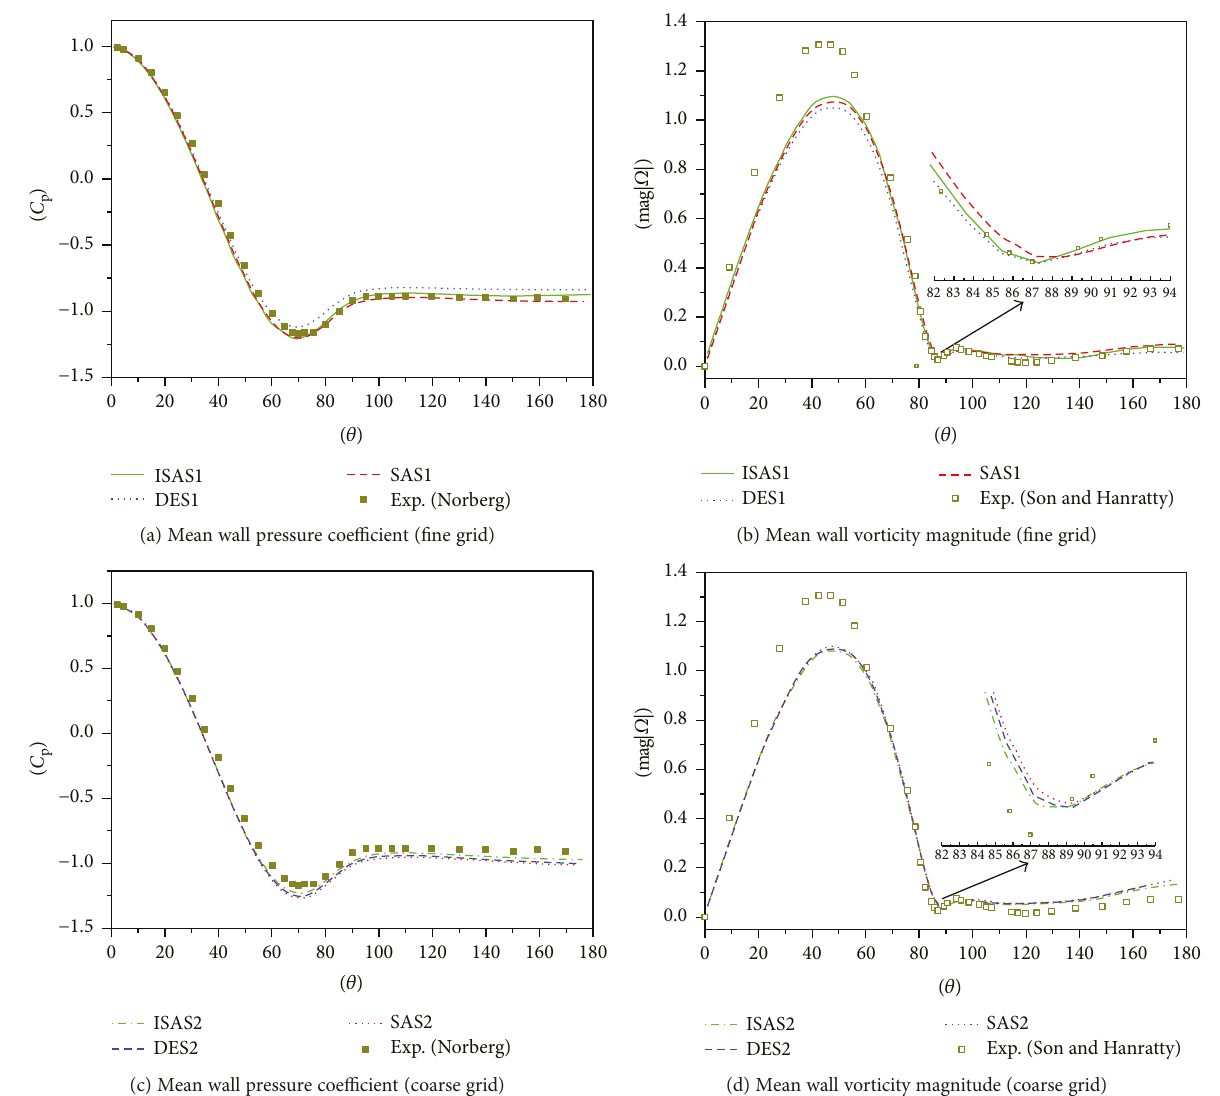
Figure 12: Comparison of the mean wall